Question: Describe this figure in one sentence.
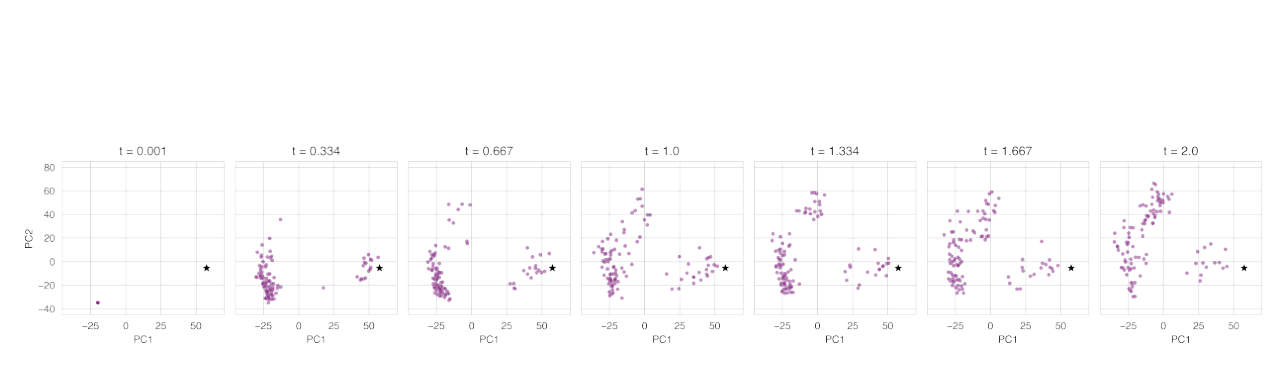
Answer: Here, we show the PCA projections of 100 stories per temperature generated using LLAMA 2-CHAT 70B and Prompt 1. While we observe that an increasing temperature seems to explore a larger region of the embedding space with a small number of samples, it does not imply that we access a broader slice of the model’s probability distribution. We merely increase the chance of generating more diversity. ⋆denotes the exemplar story.